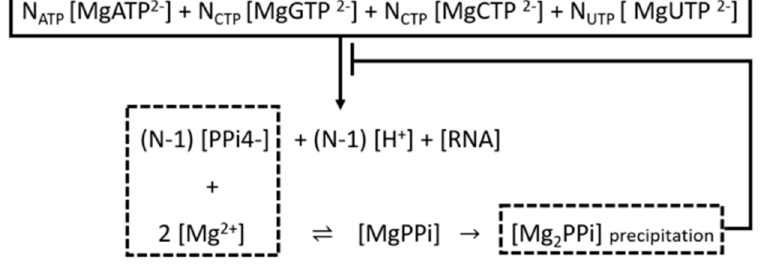
Figure 5. Schematic diagram of the IVT kinetic model, applied to the Aspen V9.0 simulator engine.